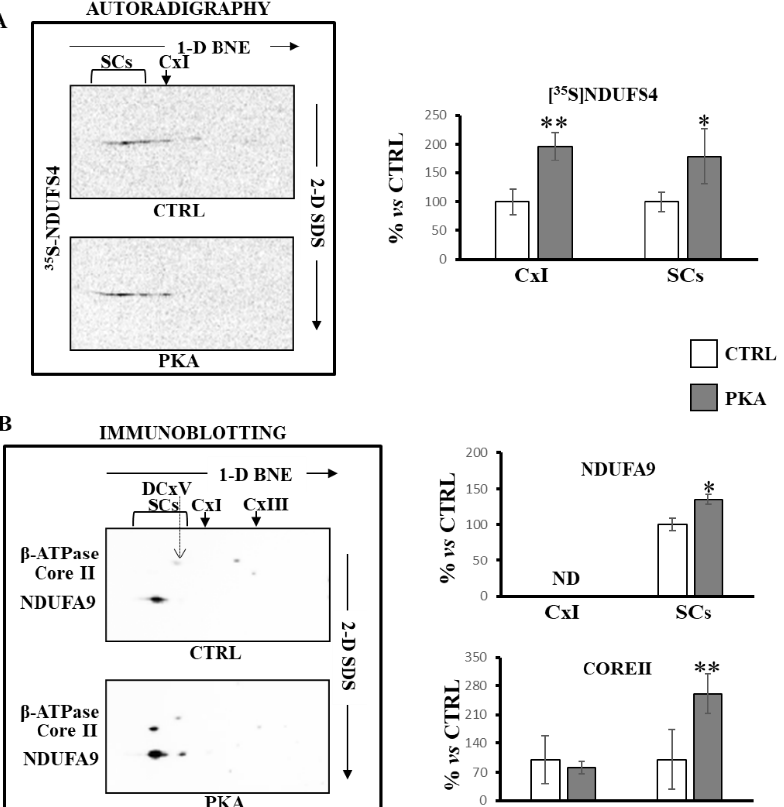
Figure 6. PKA addition to mitochondrial import experiments increased supercomplexes containing complex I and complex III. RRL translation mixture containing the newly synthesized [ 35 S]-Met labeled NDUFS4 protein was added to the import mixture containing RLM in absence (CTRL) and in the presence of PKA. After 60 min incubation at 30 ◦ C, mitochondria were spun down. The solubilized pellets were analyzed by 1D-BNE/2D-SDS PAGE. ( A ) Representative images of autoradiography. The histograms represent the percentage of ADU of autoradiography revealed spots ([ 35 S]-Met NDUFS4) in free complex I (CxI) and in supercomplexes (SCs) of PKA-treated samples with respect to untreated cells (CTRL). The complex alignment of radioactive spots was performed by using first dimension radioactive bands of the same lanes. ( B ) Representative images of immunoblotting analysis with antibodies specified in the figure. The histograms represent the percentage of ADU of PKA-treated samples with respect to untreated cells (CTRL) of immuno-revealed spots by antibodies against NDUFA9 and CORE II in free complex I (CxI) and complex III (CxIII) and in supercomplexes (SCs). The complex alignment of immuno-revealed spots was performed by using the β -subunit antibody revealing the dimeric form of ATP synthase (DCxV). The values are the means ± SD of three different experiments. (PKA vs. CTRL, * p < 0.05, ** p < 0.01, Student’s t -test). For more details, see under Materials and Methods.